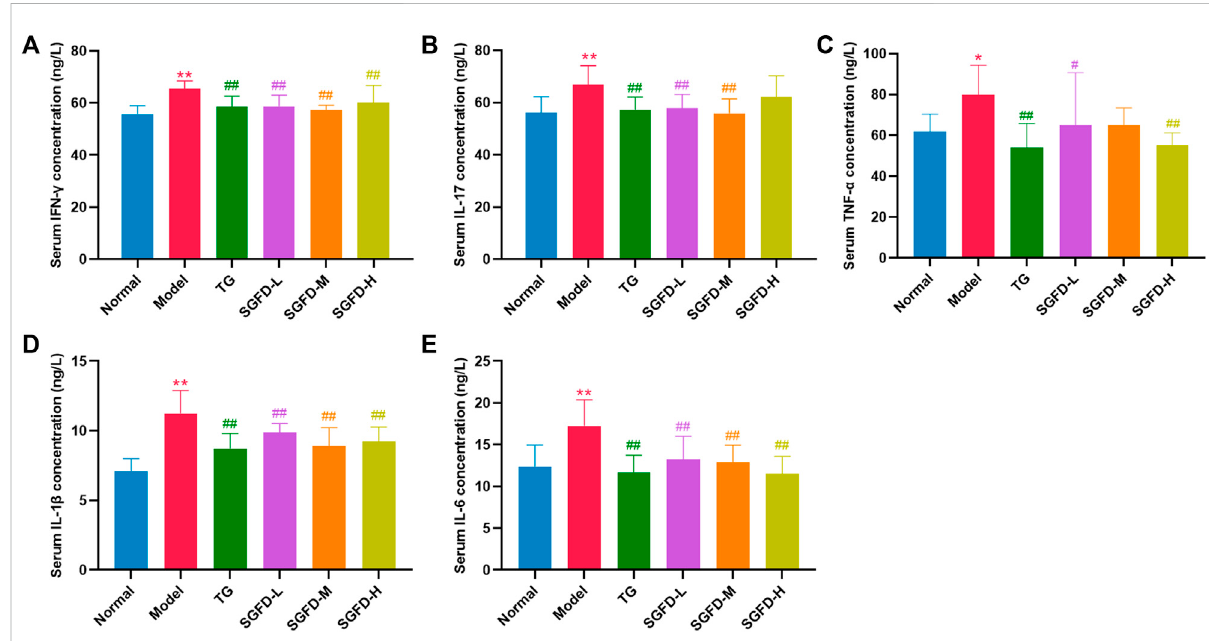
FIGURE 8 EffectsofSGFDontheserumlevelsofin fl ammatorycytokines. (A) .SerumIFN- γ concentration. (B) .SerumIL-17concentration. (C) .SerumTNF- α concentration. (D) . Serum IL-1 β concentration. (E) . Serum IL-6 concentration. Data were shown as mean ± SD ( n = 8). * p < 0.05, ** p < 0.01 vs. normal group; # p < 0.05, ## p < 0.01 vs. model